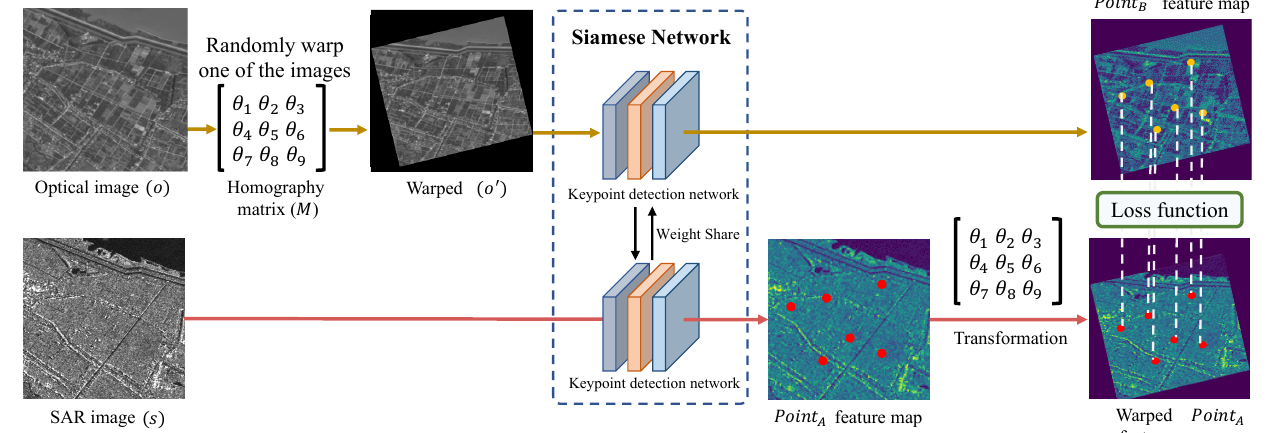
Figure 3. Self-supervised training process for keypoints. First, a randomly selected image from a strictly pixel-aligned remote sensing image is subjected to a projection transformation. Then, the warped image and the other image are simultaneously fed into the detection network with shared weights for feature point extraction. Finally, the losses of corresponding keypoints are computed by the projection transformation